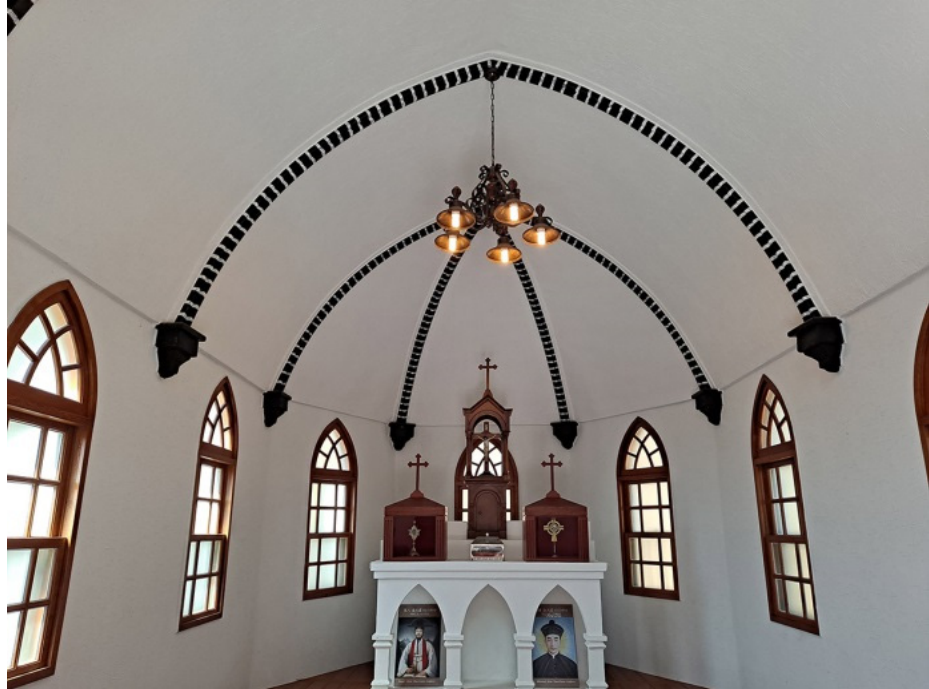
Figure 7. Interior image of the Memorial Church [source: photo by author].